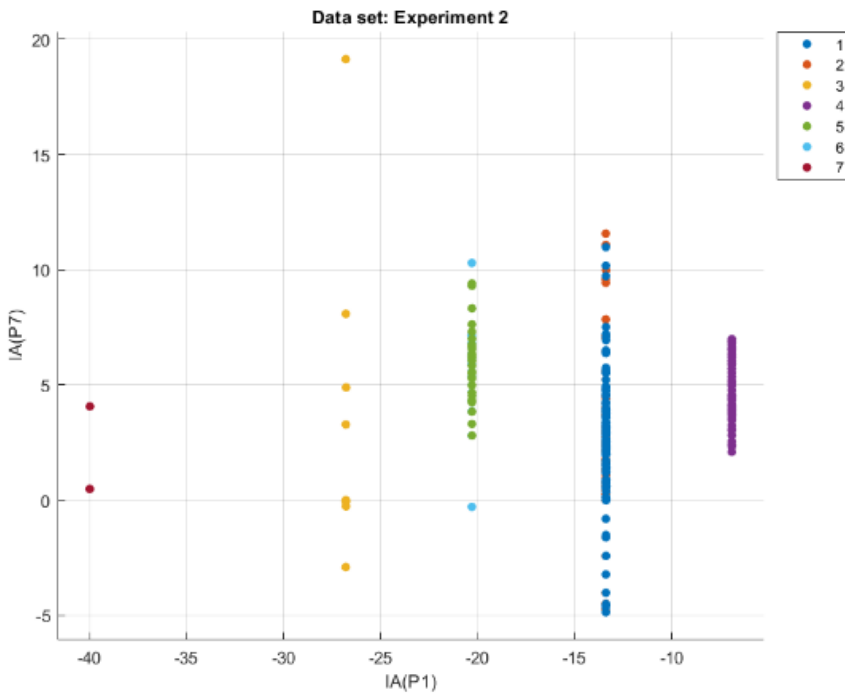
Figure 15. Data set of experiment 2.